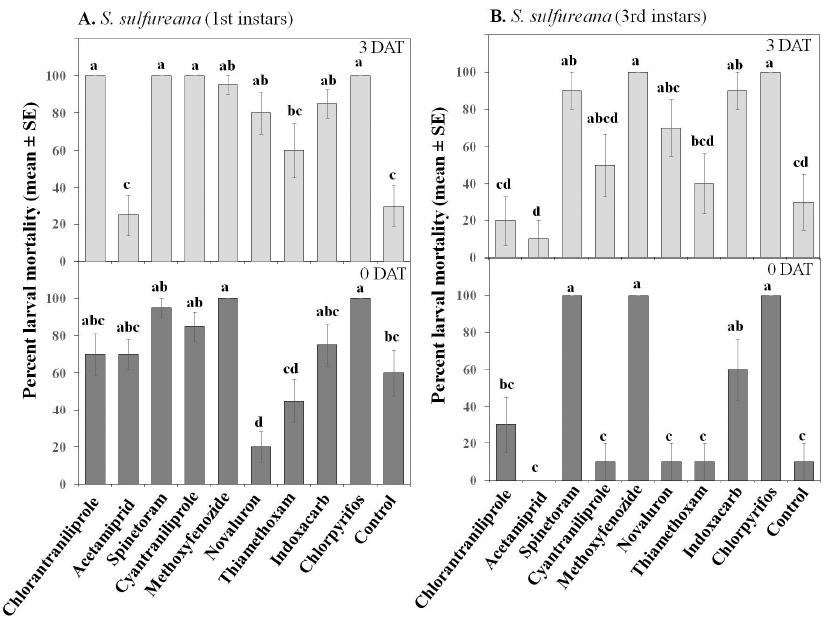
Figure 2. Effect of various insecticides on Sparganothis sulfureana 1st ( A ) and 3rd ( B ) instar larvae after exposure to 2 h (0 DAT) and 3 DAT laboratory-aged residues. DAT = days after treatment. Bars with the same letter are not significantly different at α = 0.05.